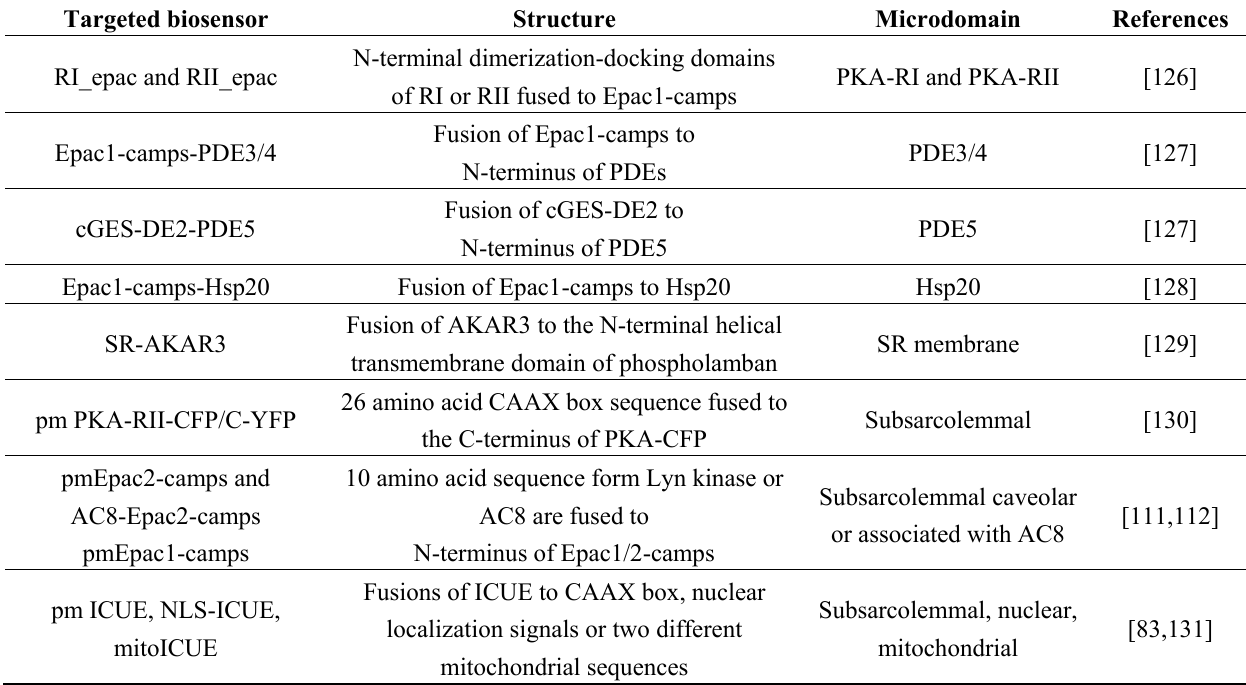
Table 2. Currently available targeted FRET biosensors for cAMP, cGMP and PKA